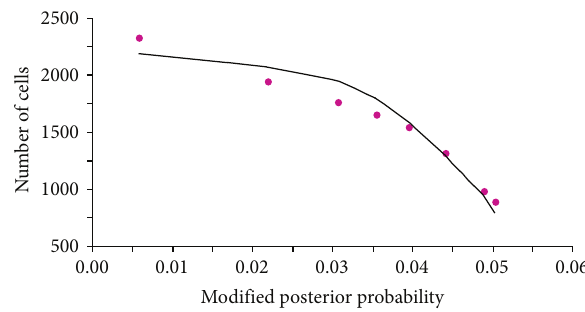
Figure 7: Modified posterior probabilities of land use suitability and numbers of corresponding points.